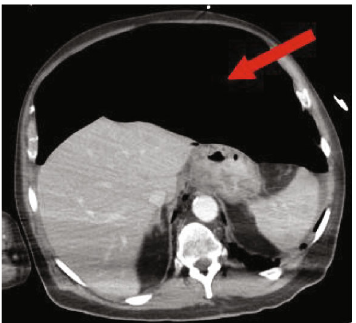
Figure 2: Free air within the peritoneal space indicated by the red arrow.